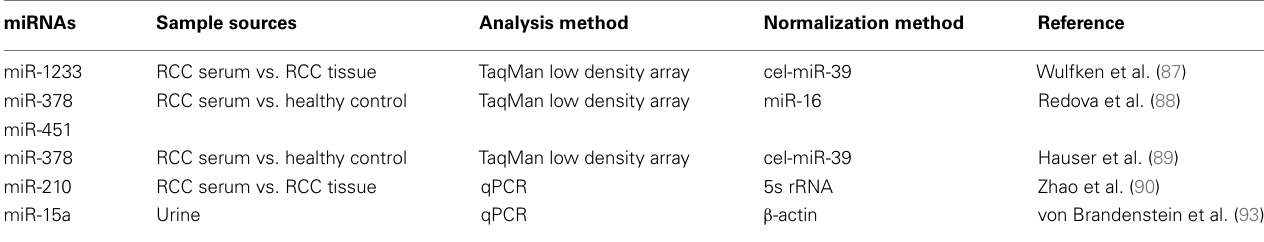
Table 1 | Circulating miRNAs in